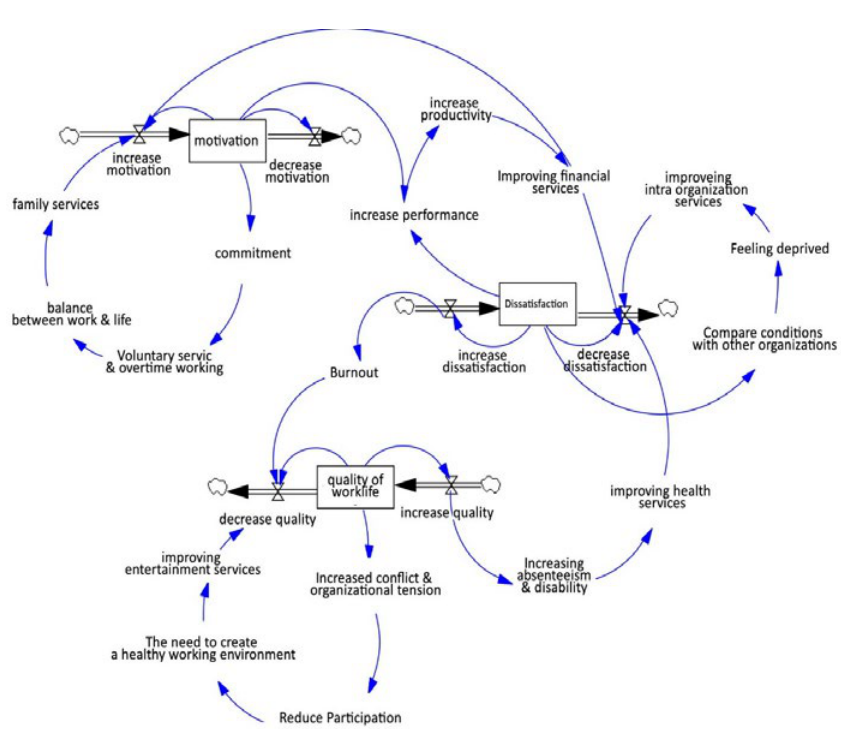
Fig. 1. Characters of causality - Fig. 1: Characters of causality - disability